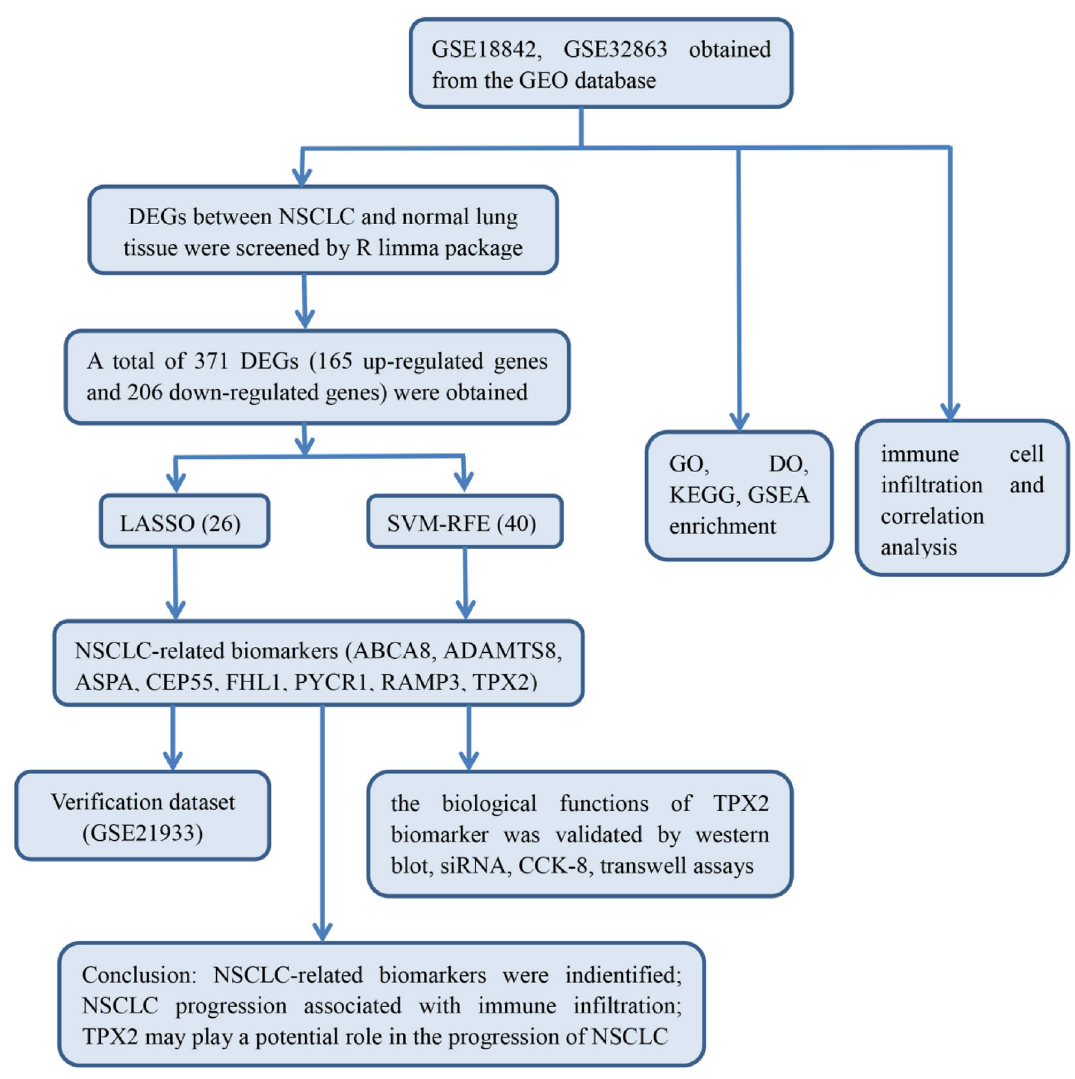
Figure 1. a flowchart of the entire analysis process to the